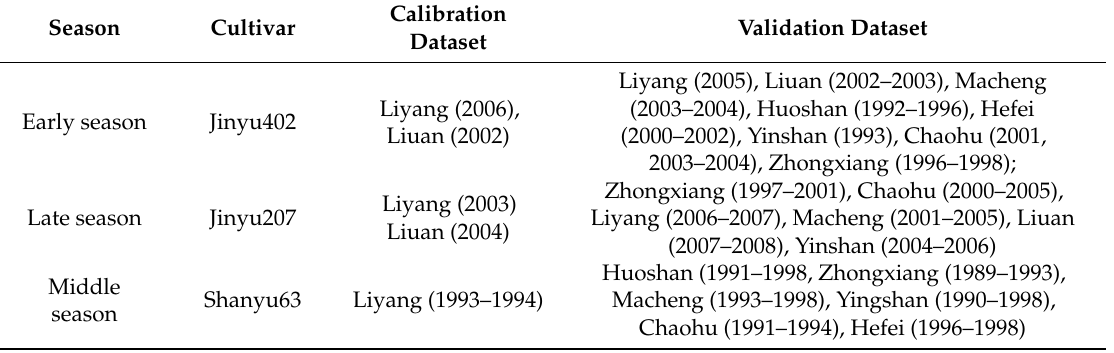
Table 2. Description of calibration and validation dataset for the ORYZA v3 crop model at 8 agrometeorological stations along the middle and lower reaches of the Yangtze River.